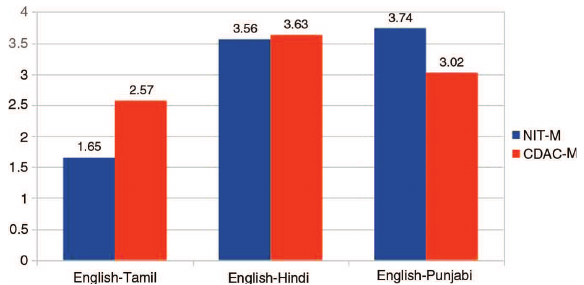
Figure 4: Comparison of Fluency Scores of NIT-M and CDAC-M Systems.